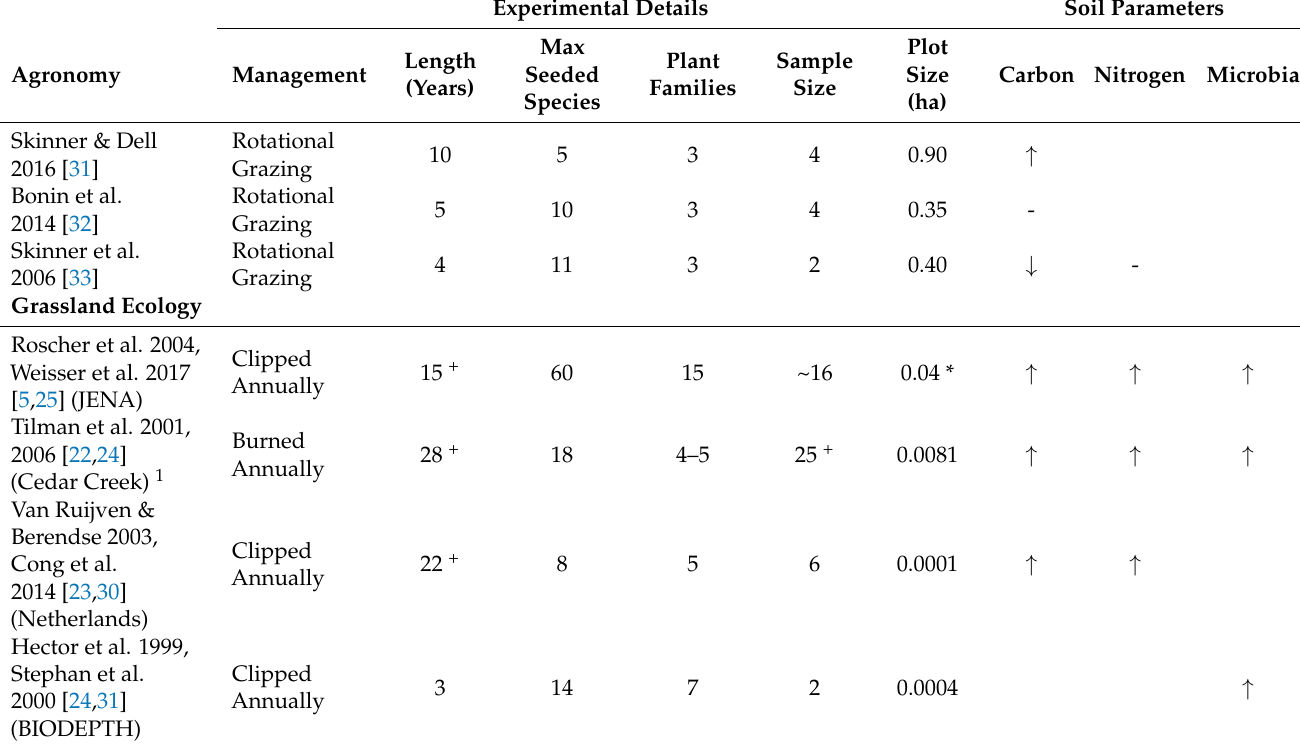
Table 1. Agronomy and grassland ecology field experiments that manipulated seeded plant diversity and associated changes in soil properties. Agronomy experiments are defined by their focus on forage species and the inclusion of grazing. Soil changes in response to elevated plant diversity are indicated as follows: ↑ = increase or improvement; ↓ = decrease; - = no change; empty fields = data not collected. Experimental Details Soil